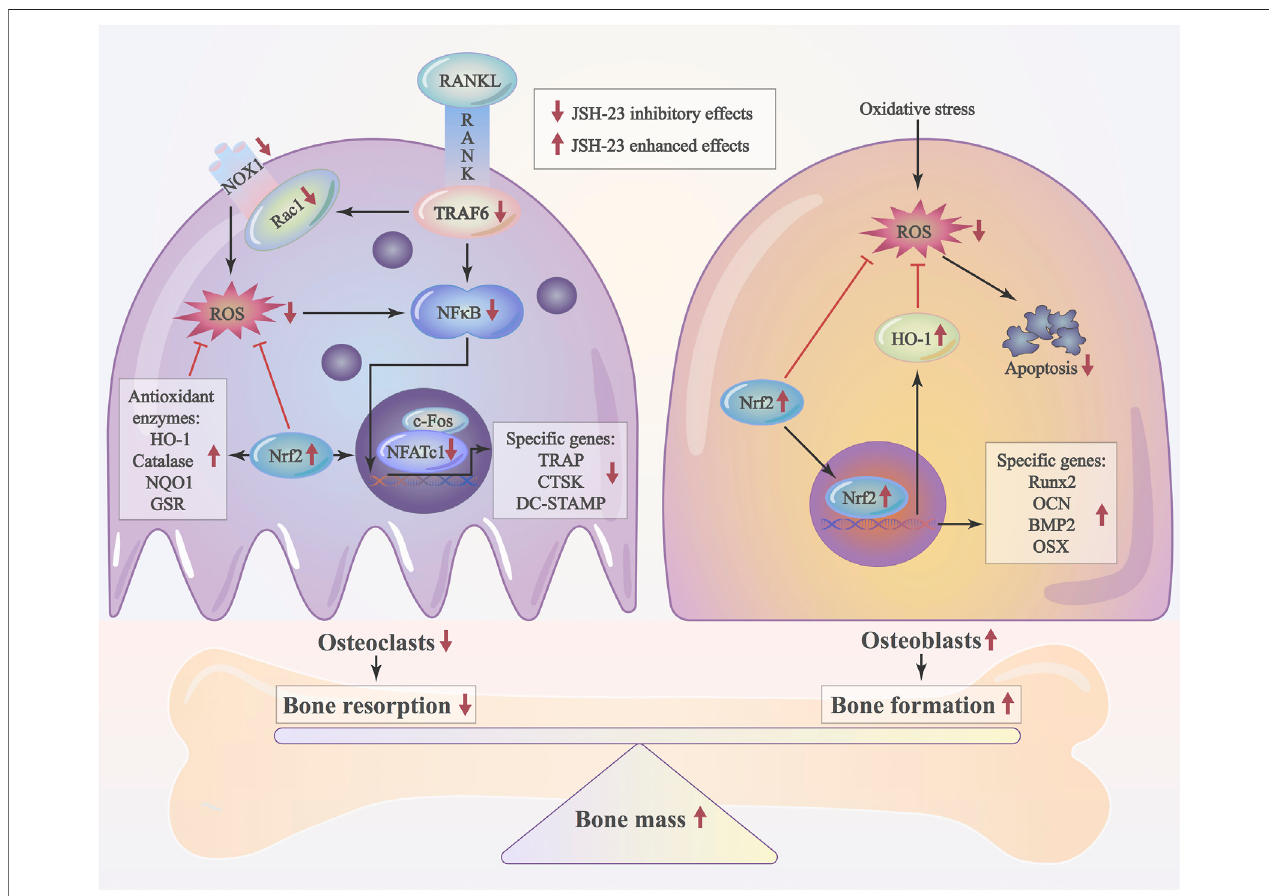
FIGURE 10 | Schematic diagram of the possible mechanism by which JSH-23 elevates bone mass by scavenging ROS production and activating Nrf2/HO-1 signaling.